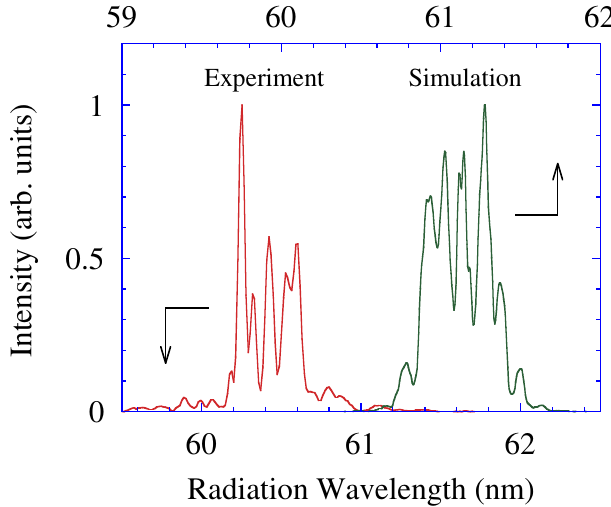
FIG. 16. (Color) Measured and simulated single-shot spectrums at around 61